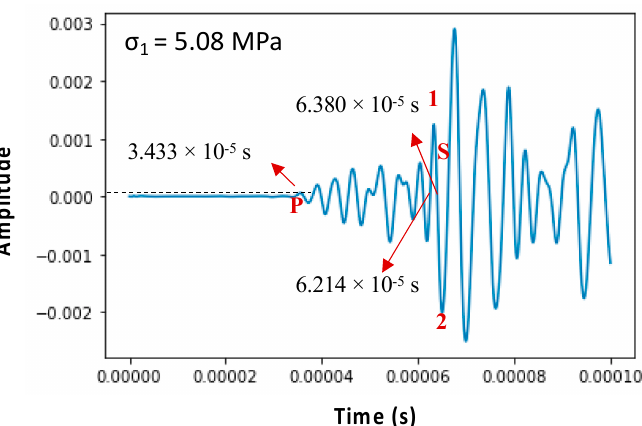
Figure 15. Acoustic signal obtained during the Siltstone TK-B1-3 UCS experiment at σ 1 = 5.08 MPa (Figure 5). Note that the error, related to S-wave arrival time picking, can be interpreted as being equal to ½ wave period.